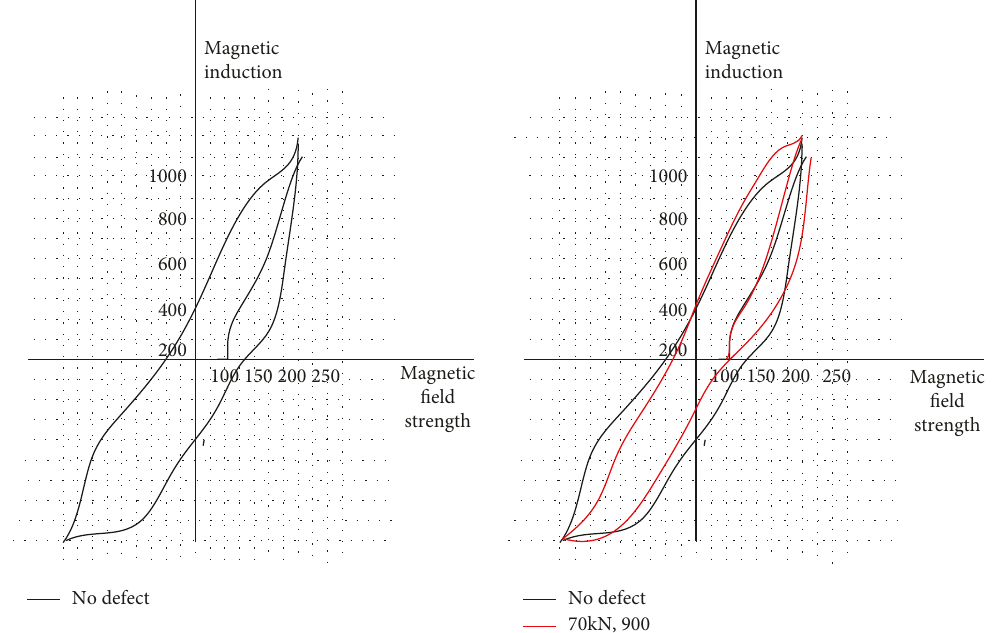
Figure 10: The hysteresis loop changes under different